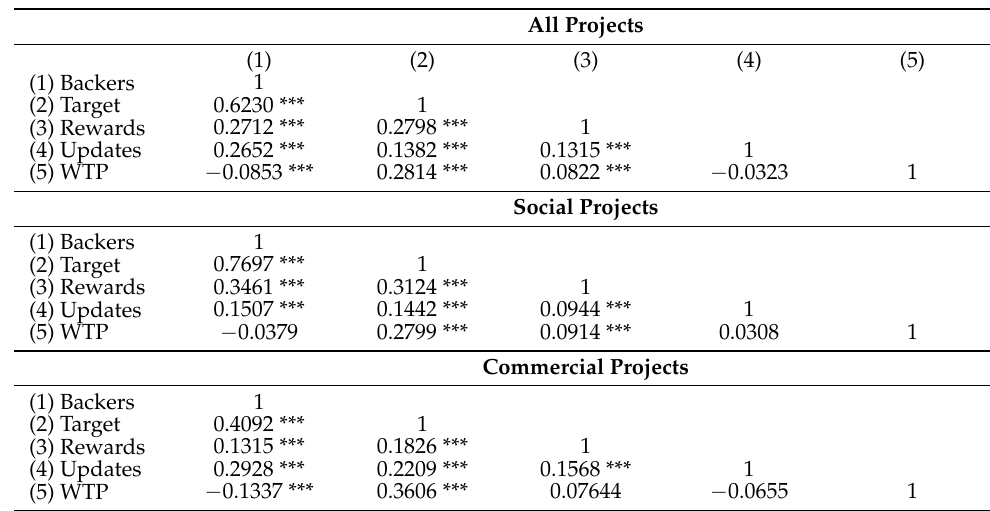
Table 2. Cross correlations between